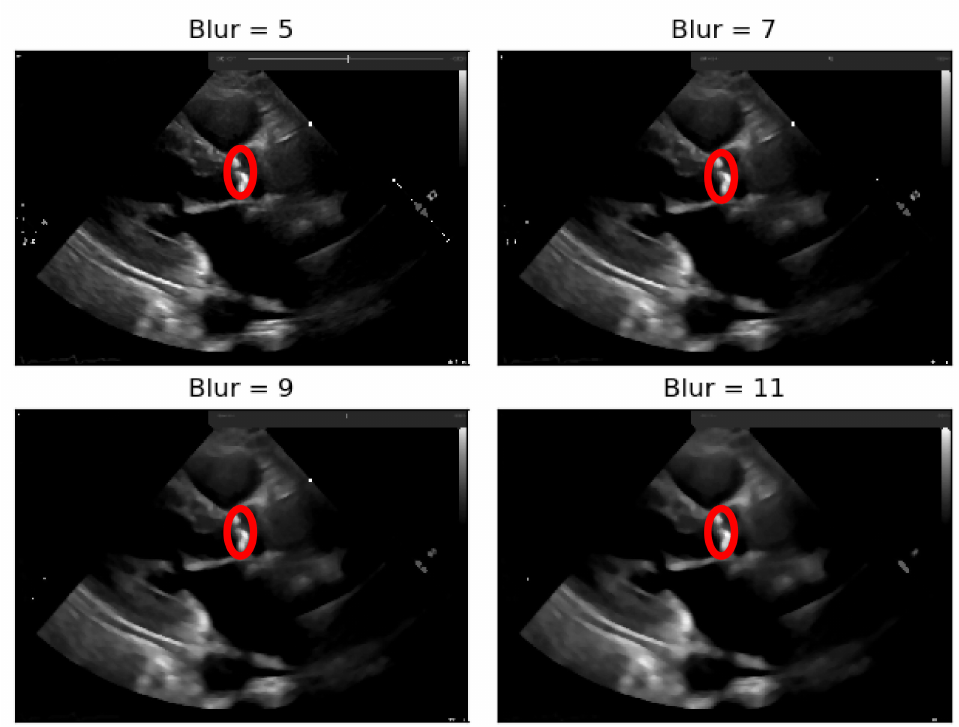
Figure 4. Echocardiography image with four levels of blurring applied—the red circle represents our ROI where the aortic valve is